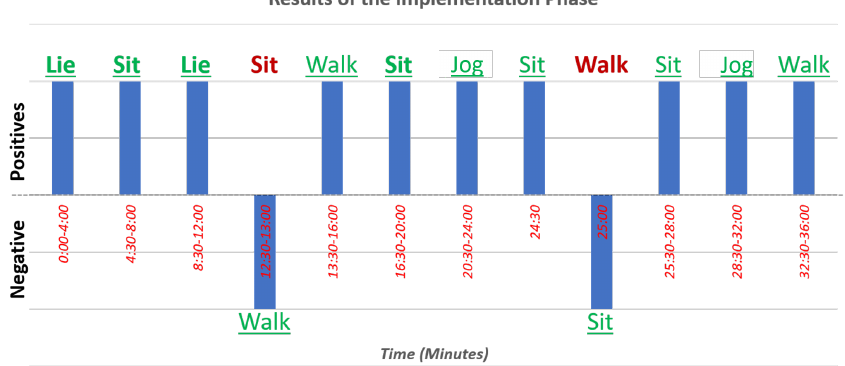
Figure 13. Results of the implementation